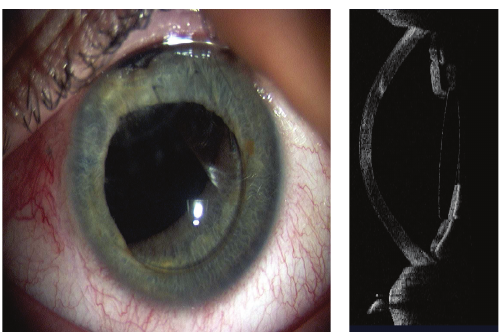
Figure 12: Subluxation of intraocular lens.